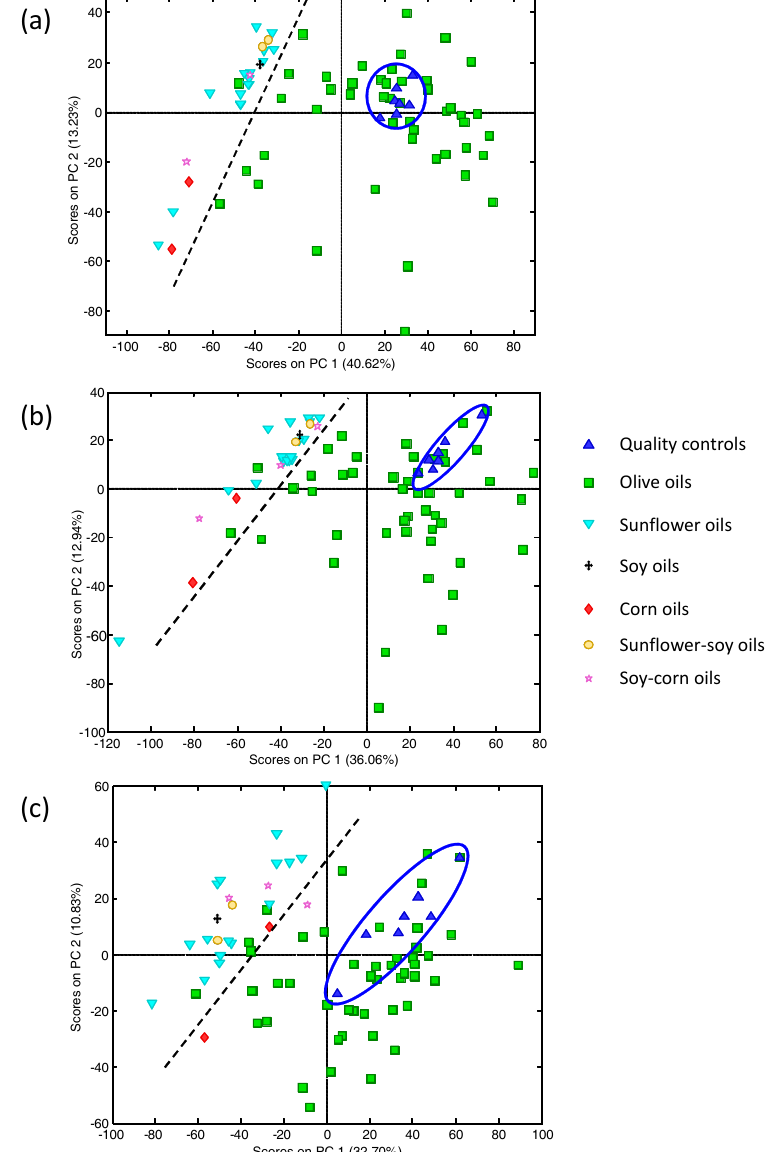
Figure 1. Scatter score plots (PC1 vs. PC2) when processing raw HPLC-UV (High performance liquid chromatography method with ultra-violet detection) chromatographic fingerprints of 47 olive oils and 25 other fruit seed oils (sunflower, corn, soy, and some mixtures of them) registered at ( a ) 257 nm; ( b ) 280 nm; and ( c ) 316 nm. Ellipse is grouping the quality controls.